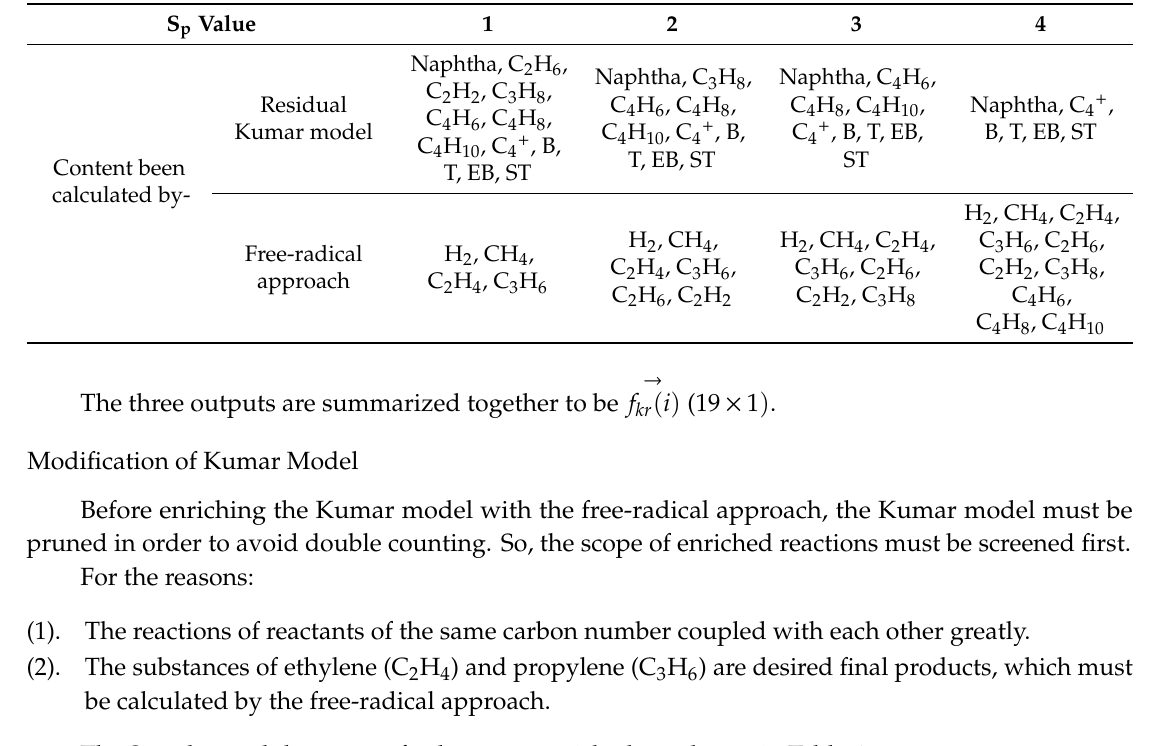
Table 4. S p value and the structure of K-R